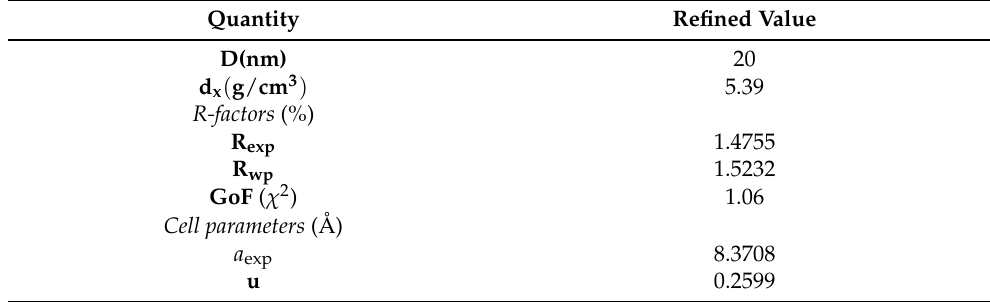
Table 1. Structural parameters for Cu 0.75 Co 0.25 Fe 2 O 4 ferrite nanoparticles. The parameters are described in the text.